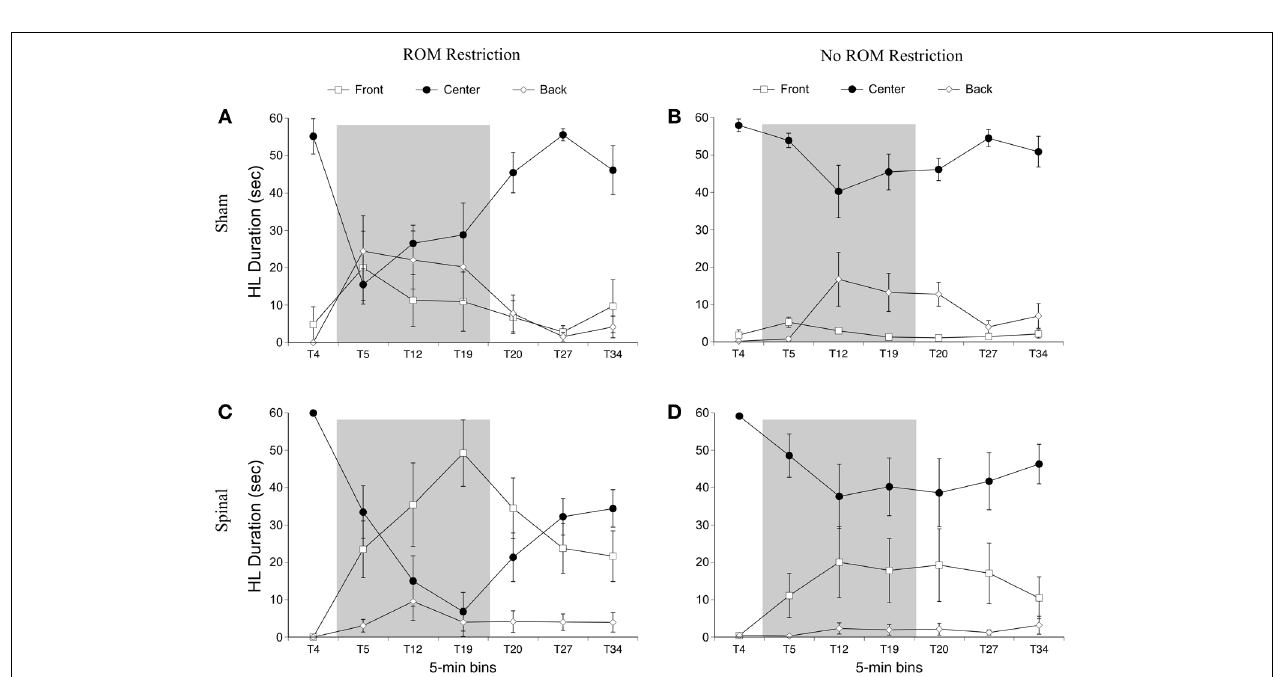
FIGURE 9 | Rostral-caudal hindlimb trajectories for sham and spinal P10 rats by ROM restriction condition. Graphs show duration of time spent in front, center, and back trajectory areas for 1-min sections during baseline, ROM restriction, and the post-ROM restriction period for (A) sham subjects